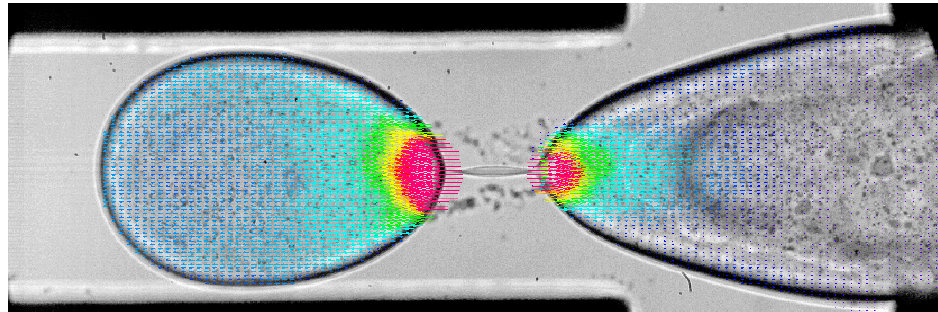
Figure 7. Snapshot of the flow field at rupture during the droplet break-up experiment performed by Carrier et al. [12]. Colors indicate velocity magnitude, max velocity 270 mm/s. Histogram thresholding (HT) dynamic mask is able to follow morphological changes during droplet formation. Channel width is 250 µm.